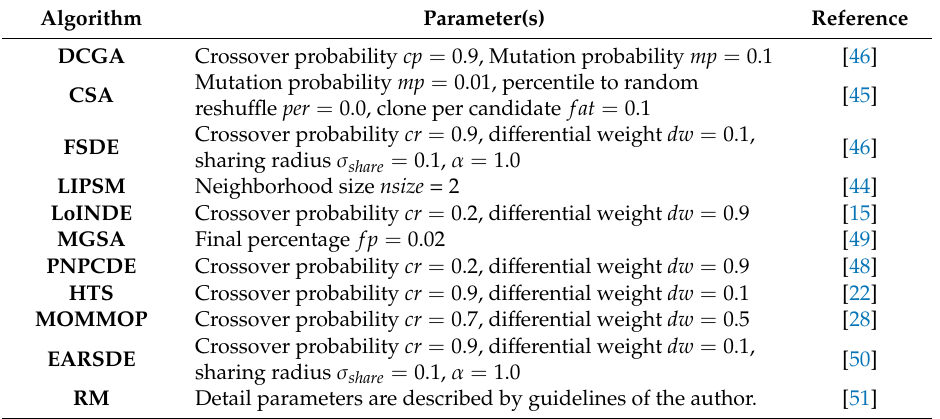
Table 1. Parameter configuration for each multimodal method used in the experimental study.